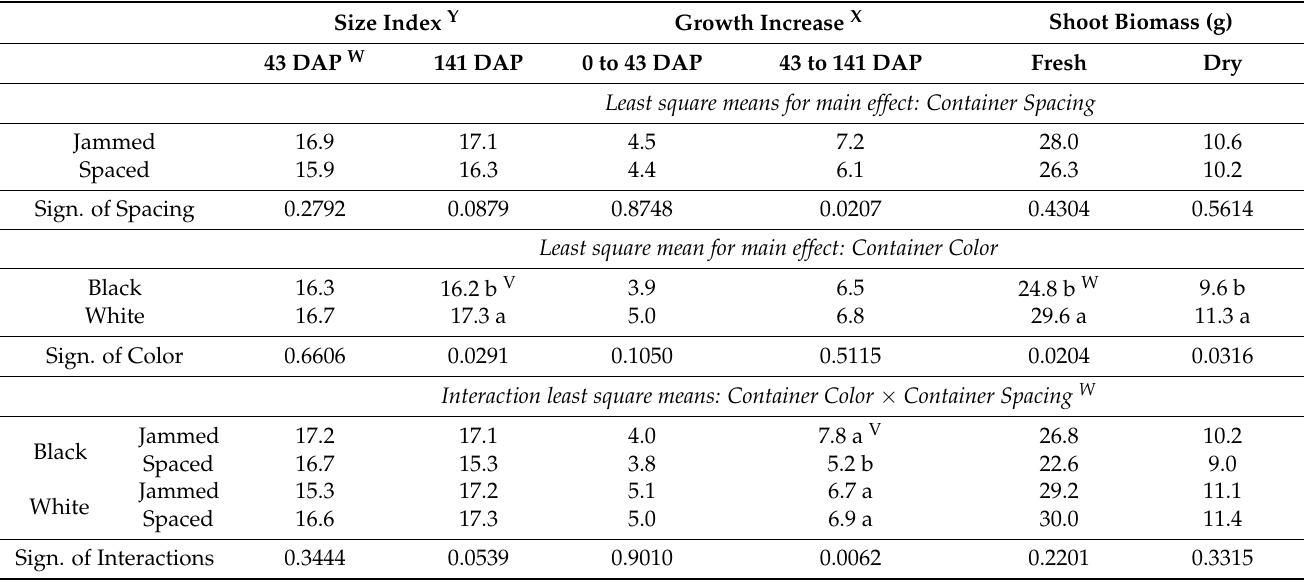
Table 1. Main effects Z and interactions of container spacing and color on ‘Soft Touch’ Japanese holly growth and shoot biomass ( n =